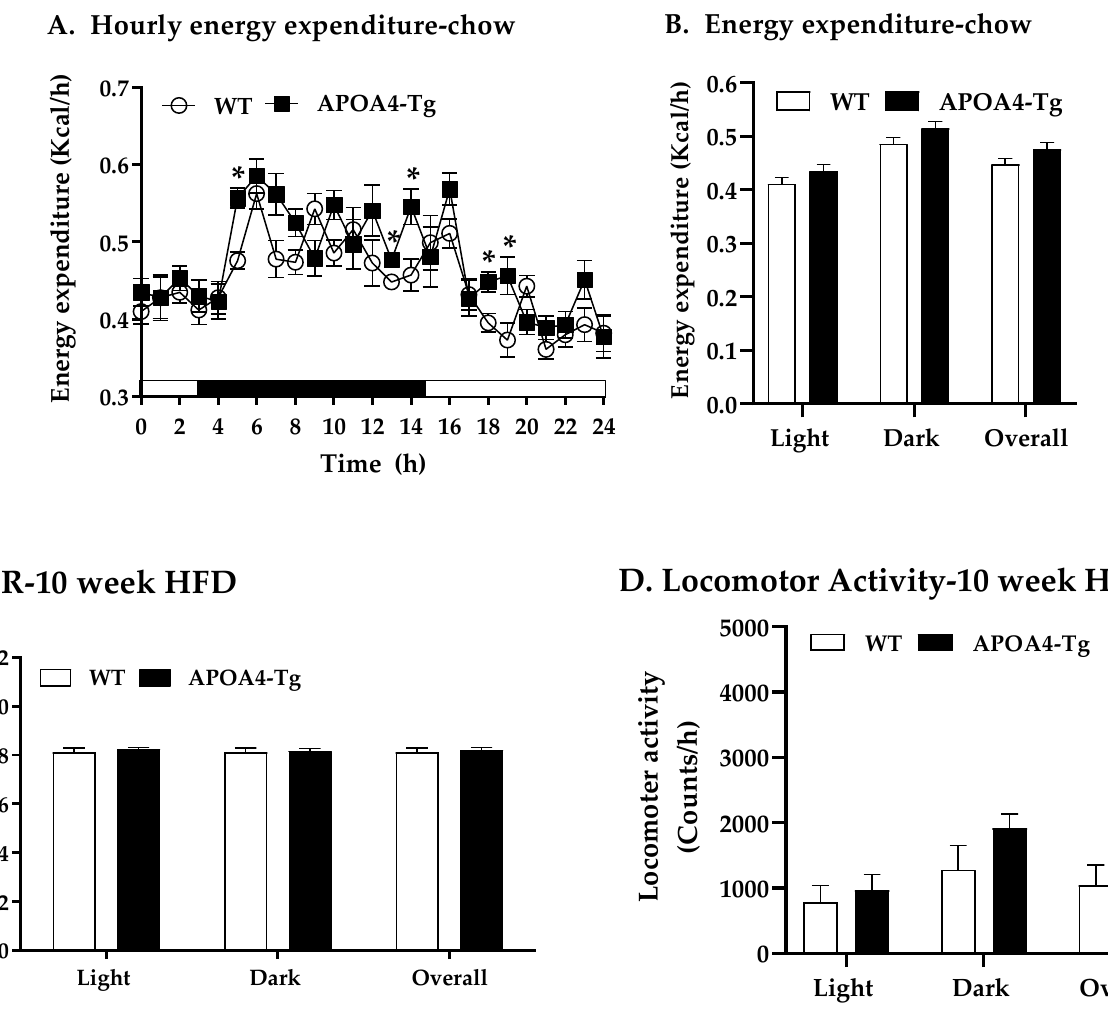
Figure 6. Hourly energy expenditure ( A ), average energy expenditure ( B ), average respiratory exchange ratio (RER, VCO2/VO2) ( C ), and locomotor activity ( D ) in mice during light and dark phases of the 10 th week of HFD feeding at 28 ◦ C. Energy expenditure was covaried for lean body mass. Data are expressed as mean ± SEM. n = 4 or 5 per group. * Represent significant differences relative to WT mice ( p < 0.05).